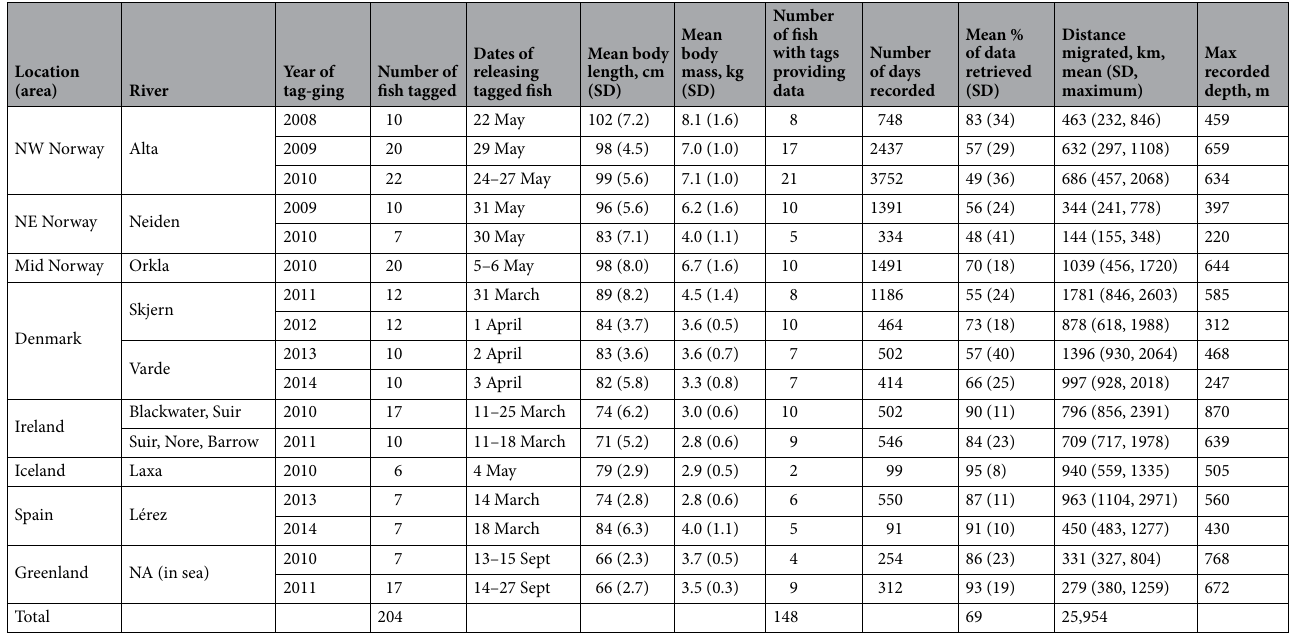
Table 1. Overview of tagged post-spawned Atlantic salmon from eleven rivers in eight geographic areas in the north-east Atlantic and maiden salmon captured off Greenland. The number of fish tagged, tagging dates and fish body size is given for each river/location each year. The number of fish with tags providing data, the total number of days recording data, mean % of the data retrieved from the tags, mean distance migrated as a straight line from the river to the pop up location, and the maximum recorded swim depth of the fish are also given. NW north-western, NE north-eastern, SD standard